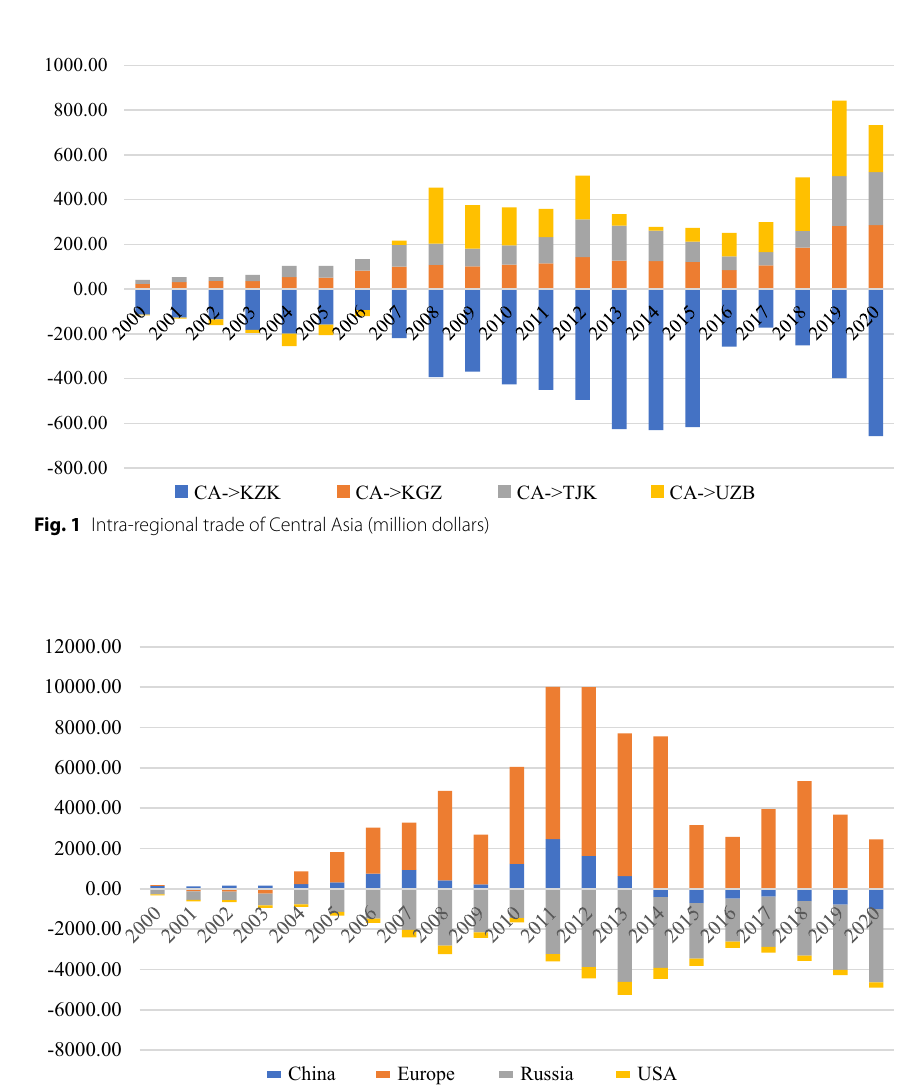
Fig. 2 Central Asia direction of trade with others (million